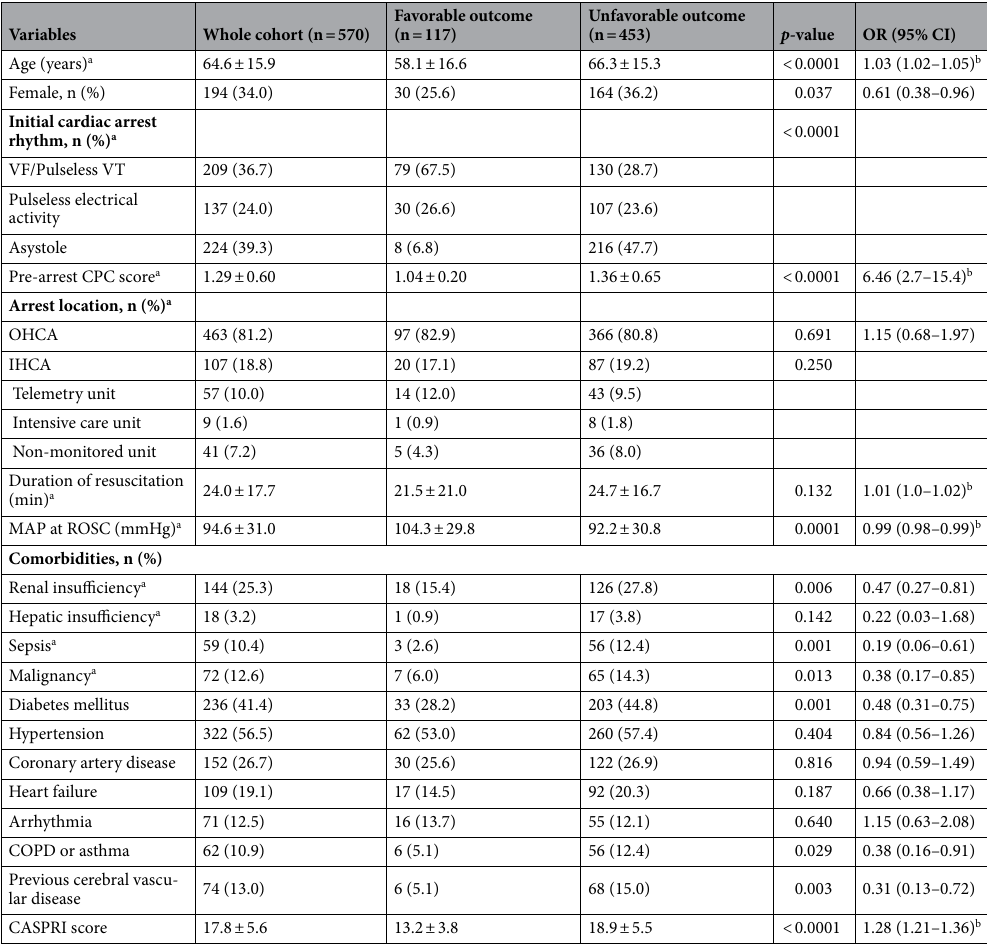
Table 1. Baseline demographic characteristics of patients according to neurological outcomes at hospital discharge. CASPRI Cardiac Arrest Survival Postresuscitation In-hospital, CI confidence interval, COPD chronic obstructive pulmonary disease, CPC cerebral performance category, IHCA in-hospital cardiac arrest, MAP mean arterial pressure, OHCA out-of-hospital cardiac arrest, OR odds ratio, ROSC return of spontaneous circulation, VF ventricular fibrillation, VT ventricular tachycardia. a Variables used to calculate CASPRI score. b Odds ratio of per unit